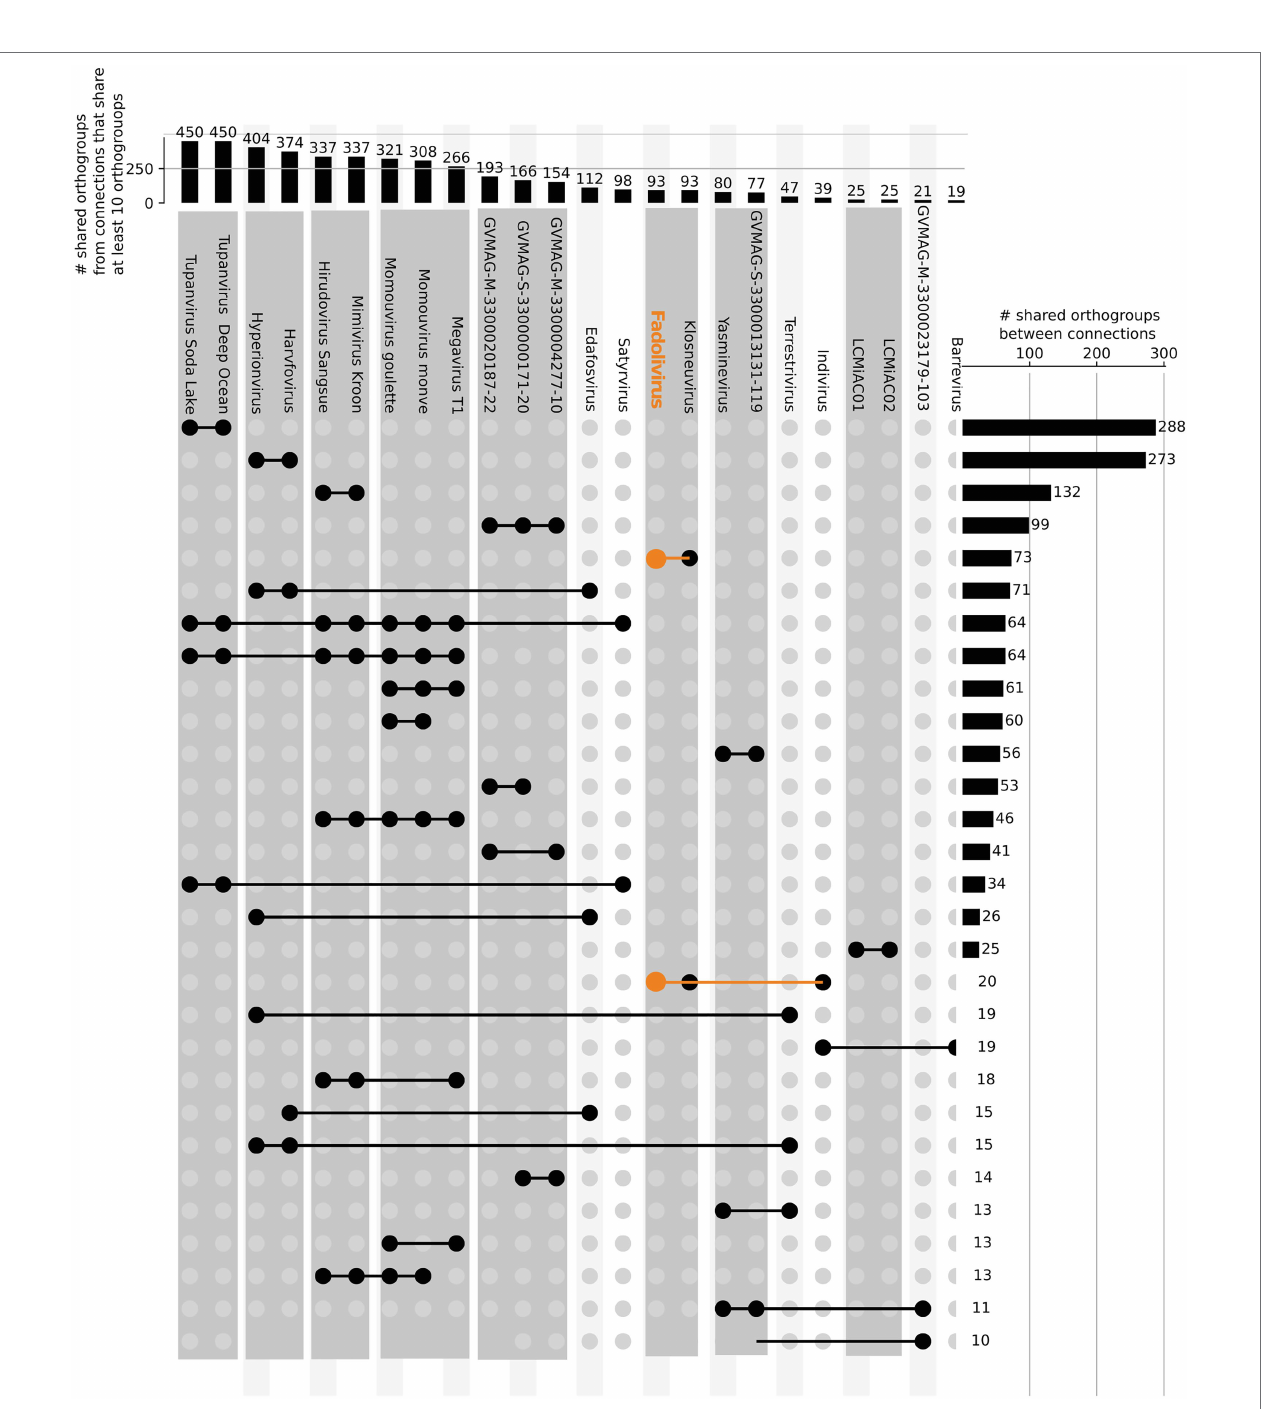
FIGURE 6 | Orthologous genes shared by viruses in the Klosneuvirinae and some Mimiviridae . Connected lines highlight viruses sharing at least 10 orthologous genes. The bars at the top panel show the total number of shared orthologs between viruses that share at least 10 orthogroups. The bars in the right panel indicate the total number of shared orthogroups between visualized groups of viral genomes (connected by lines in the same